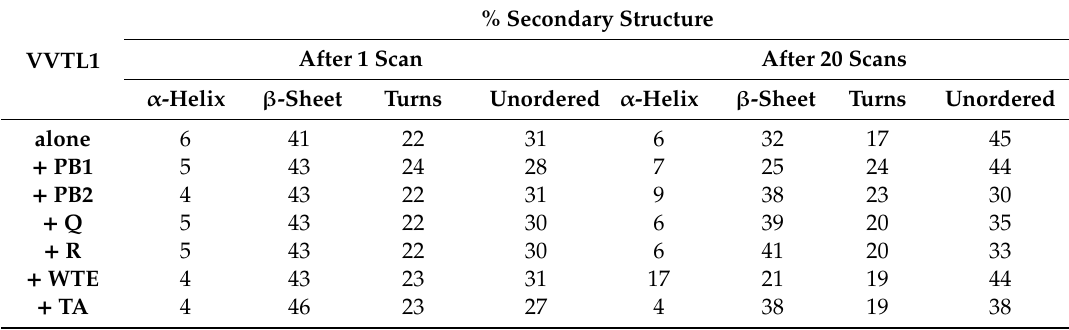
Table 3. Secondary structure content of VVTL1 (0.400 mg / mL) alone or in the presence of phenolic compounds after 1 and 20 scans in UV photo-denaturation assay. Secondary structure was calculated by CDApps [45] using CONTINLL algorithm [46].